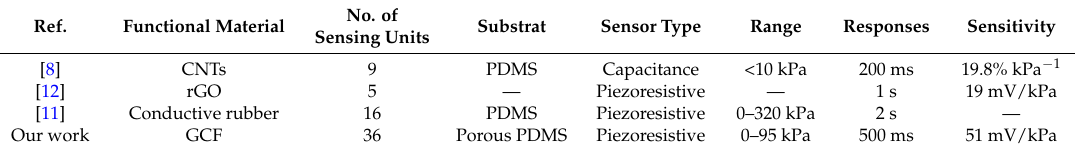
Table 2. Comparison of similar sensor arrays, previously